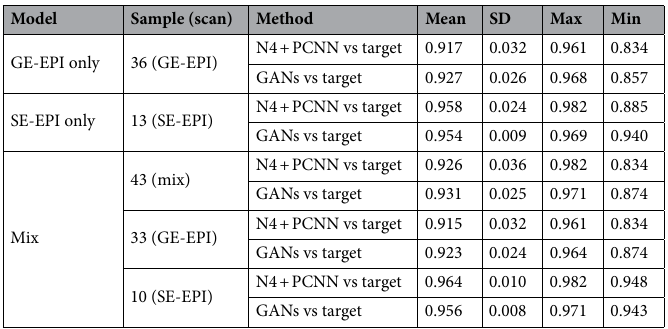
Table 2. Dice index of GANs and N4 + PCNN outputs.